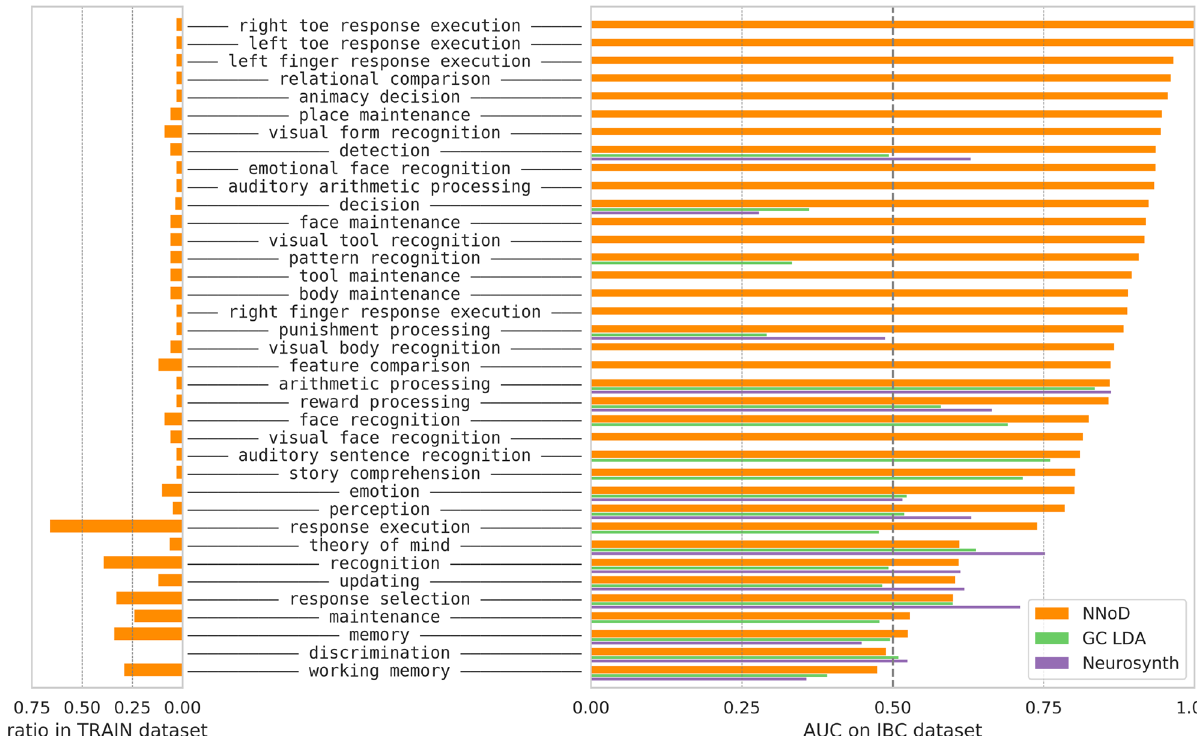
Figure 4. Performances on exactly-matched concepts. On the left, we display the label frequencies in the training set. On the right, we evaluated the AUC of NNoD on 37 concepts matched in the IBC dataset, after training it to decode 96 concepts from on all the other collections. Using pre-trained GCLDA and NeuroSynth models, we compared NNoD results for the concepts on which these models were also trained.